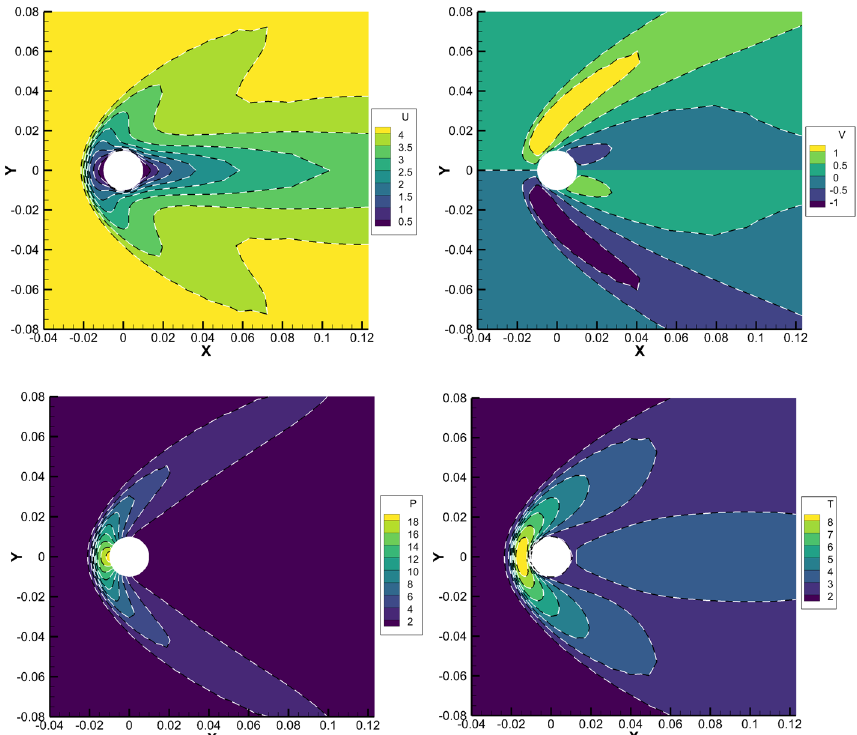
Fig. 14 Comparison of u -velocity, v -velocity, pressure and temperature contours for flow around a circular cylinder at Ma 5 and Kn 0.1 (ADUGKS: colored background with black solid line; DUGKS: white dashed = =